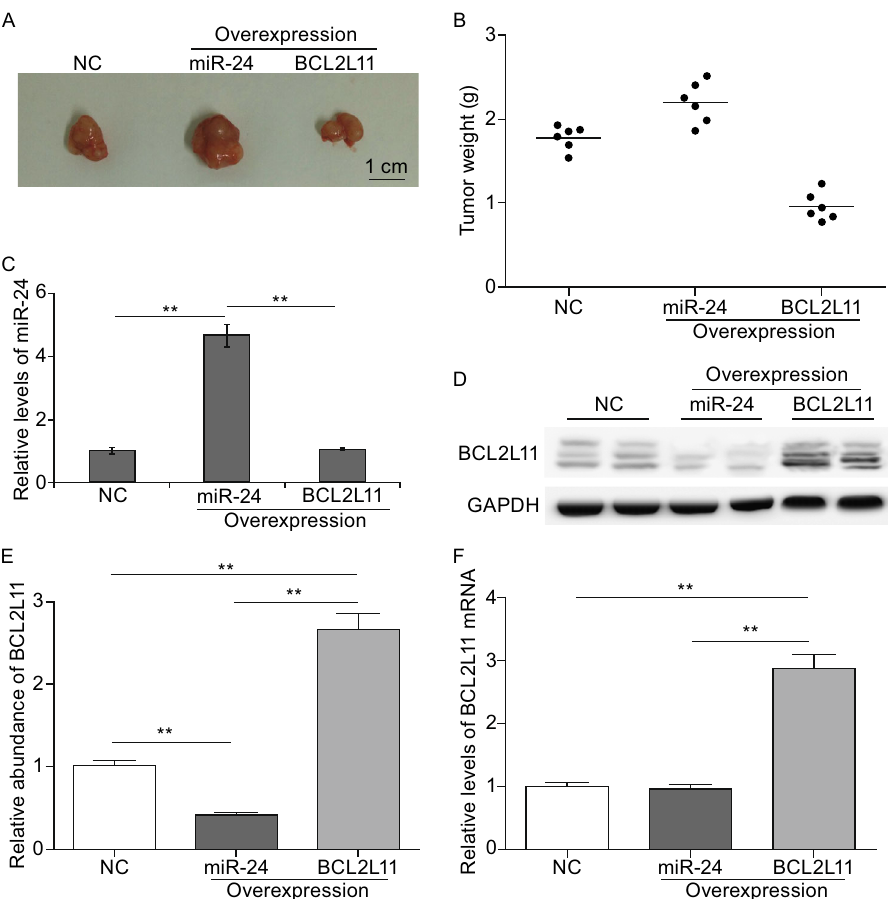
Figure 6. MiR-24 promotes tumorigenesis by suppressing BCL2L11 expression in vivo . (A) Representative image of tumors excised from nude mice. SGC7901 cells were treated with miR-24-overexpressing lenti-virus, BCL2L11-overexpressing lenti-virus and the control lenti-virus respectively, and cells were implanted in BALB/c mice. (B) Weight of tumors from mice implanted with SGC7901 cells. (C) Quantitative RT-PCR analysis of miR-24 in implanted tumors. (D – F) BCL2L11 expression in implanted tumors. Western blot analysis of BCL2L11 levels (D); quantitative analysis of (E); Relative levels of BCL2L11 mRNA in implanted tumors (F). ** indicates P <